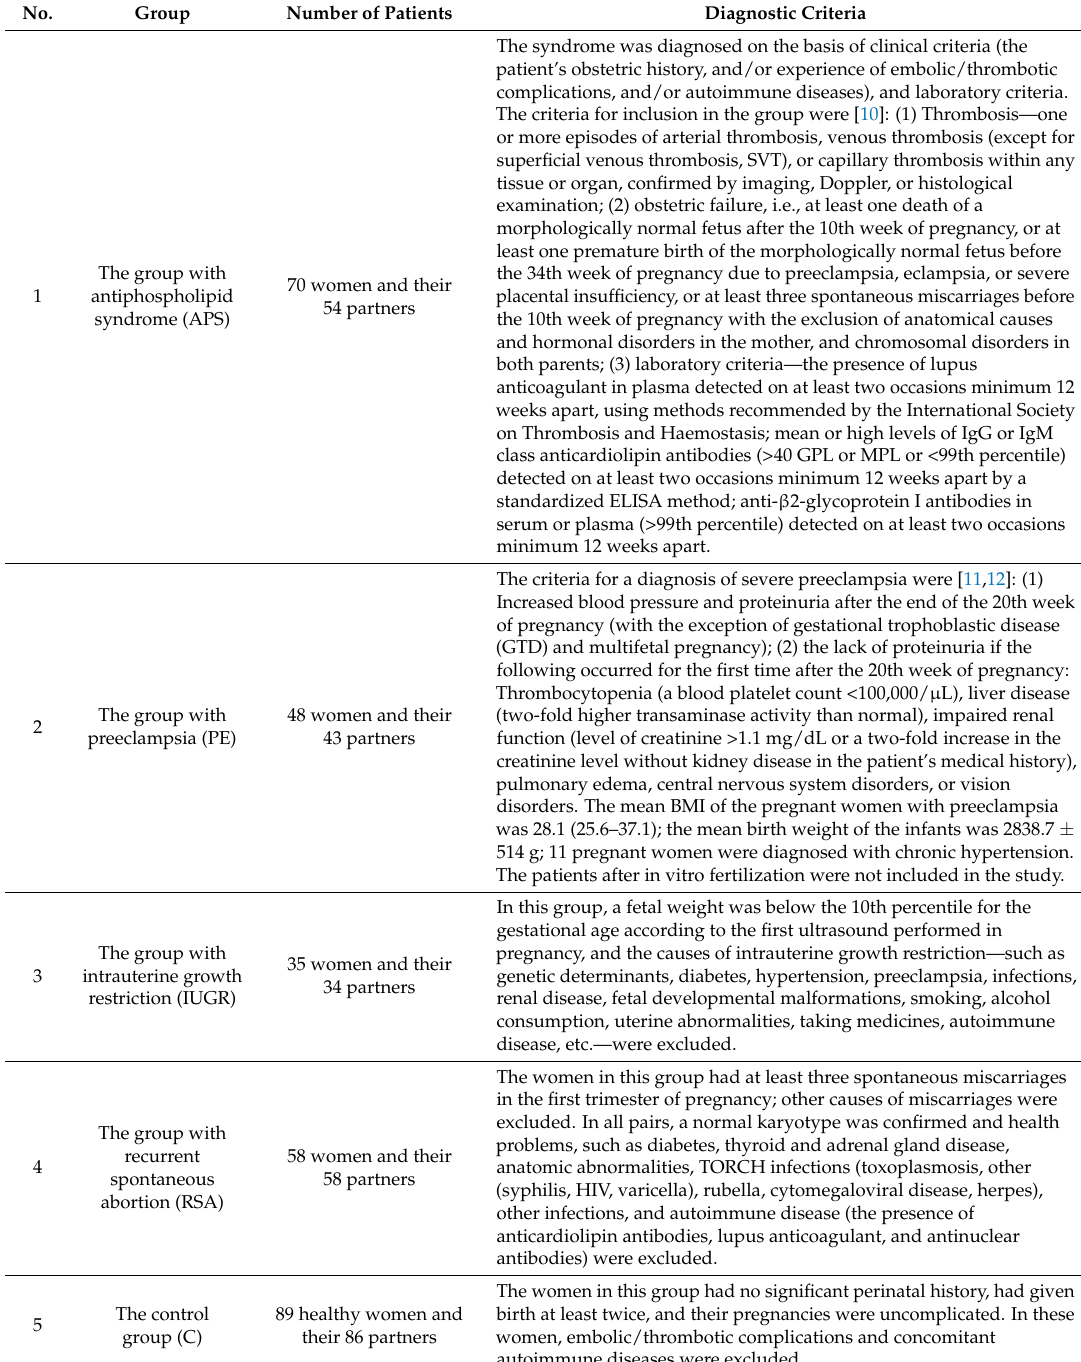
Diagnostic criteria for pregnancy complicated by the antiphospholipid syndrome, preeclampsia, intrauterine growth restriction, or recurrent spontaneous